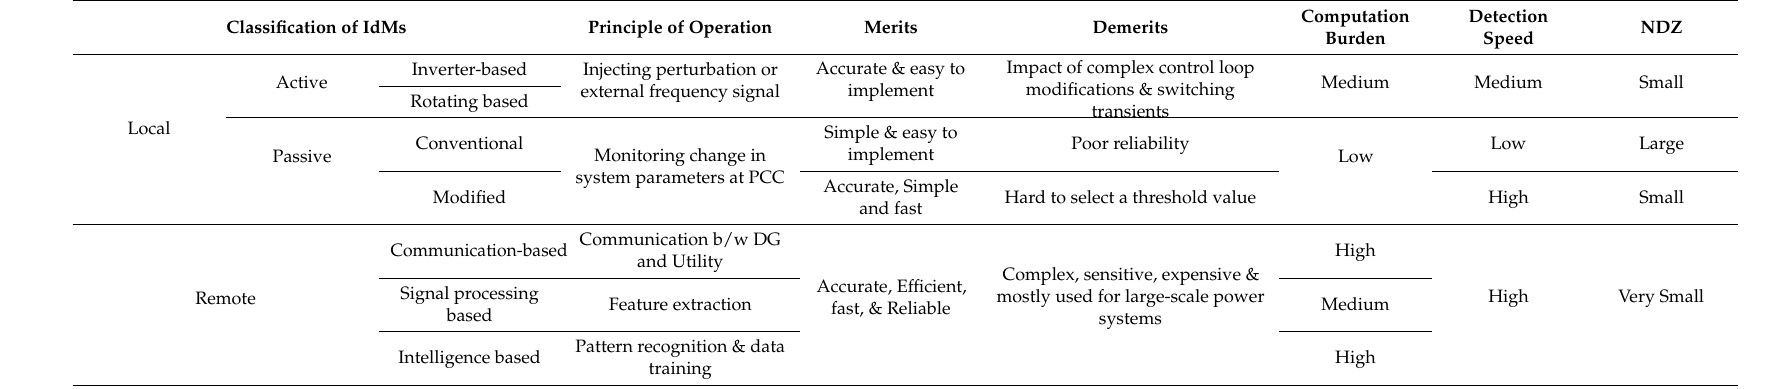
Table 1. Characterization of